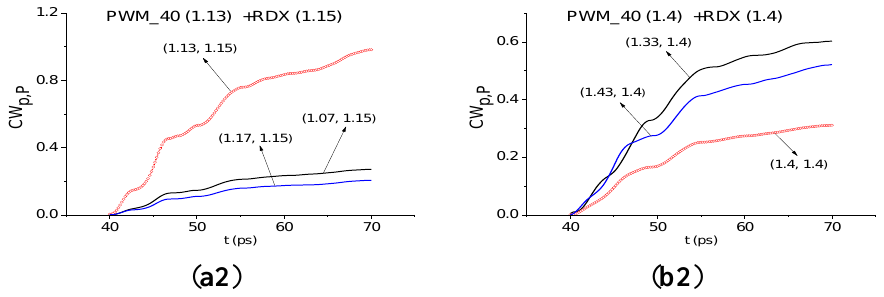
Figure 17. Fourier spectra of the PWM_40 signal ( a ) and Reference signal ( b ) in the time interval t = [40, 65] ps; Fourier spectra of the PWM_40 signal ( a1 ) and Reference signal ( b1 ) in the time interval t = [20, 40] ps; integral characteristics CW p , P ( t n ) detecting the frequencies ν = 1.13 THz ( a2 ); 1.4 THz ( b2 ) for PWM_40 and RDX_Air signals.